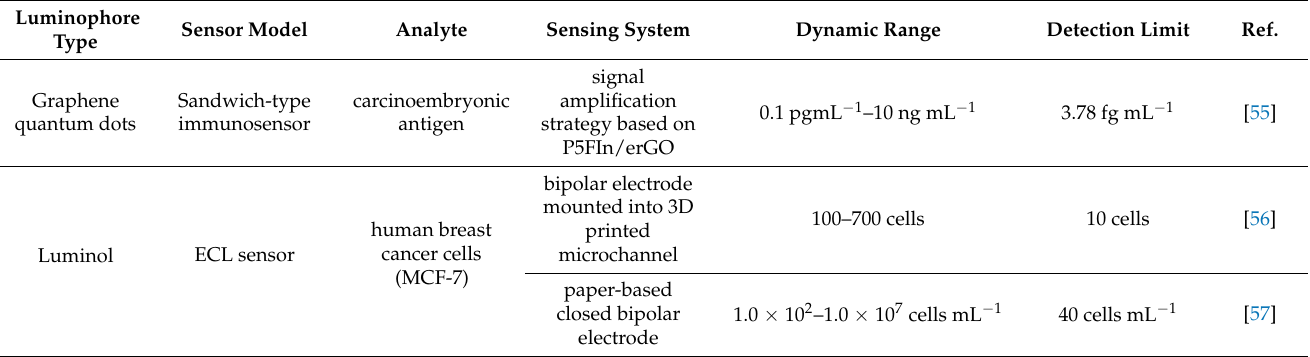
Table 1. Overview of some lab-on-a-chip chemiluminescence biosensors for cancer detection: design, dynamic range, and detection limit of different biosensing strategies.